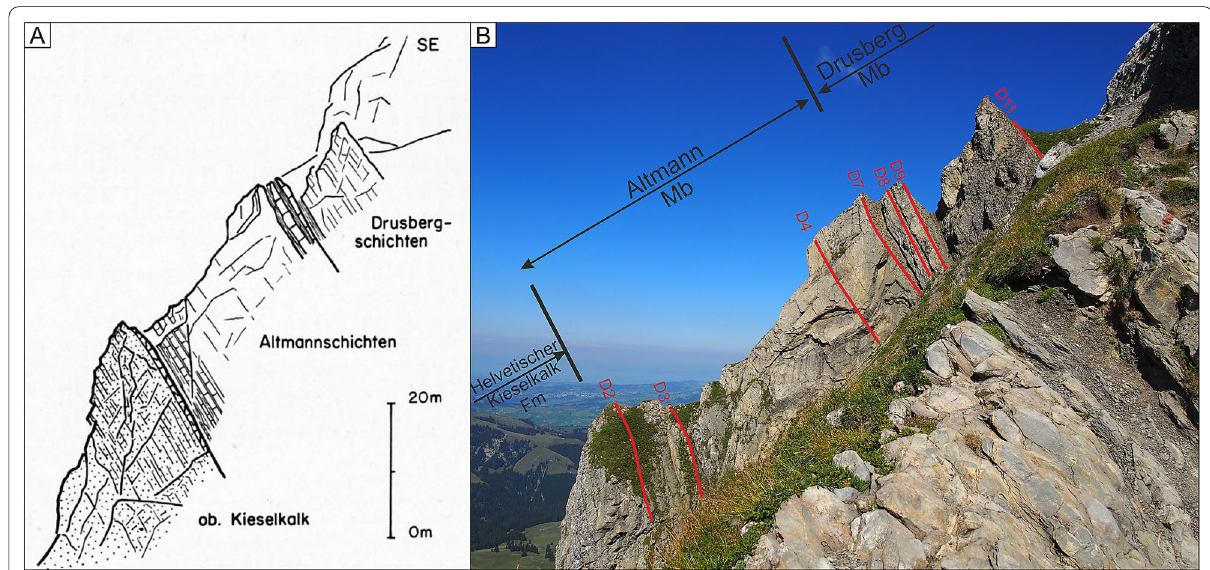
Fig. 3 A Illustration of the Tierwis profile (Kempf, 1966) situated on the north-western side of Grauchopf (Coordinates 2743 ′ 218/1234 ′ 893/2040). B Photograph of the same section, on which the main lithostratigraphic units and the discontinuity surfaces are marked